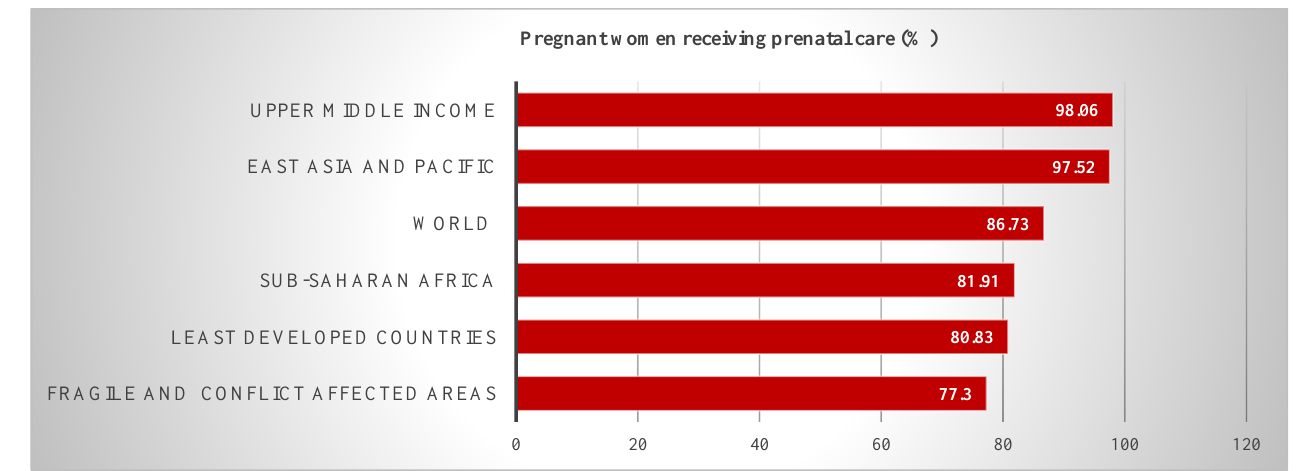
Figure 2. Pregnant women receiving prenatal care (2020). Source: Graph computed using statistics from the World Bank (2022).